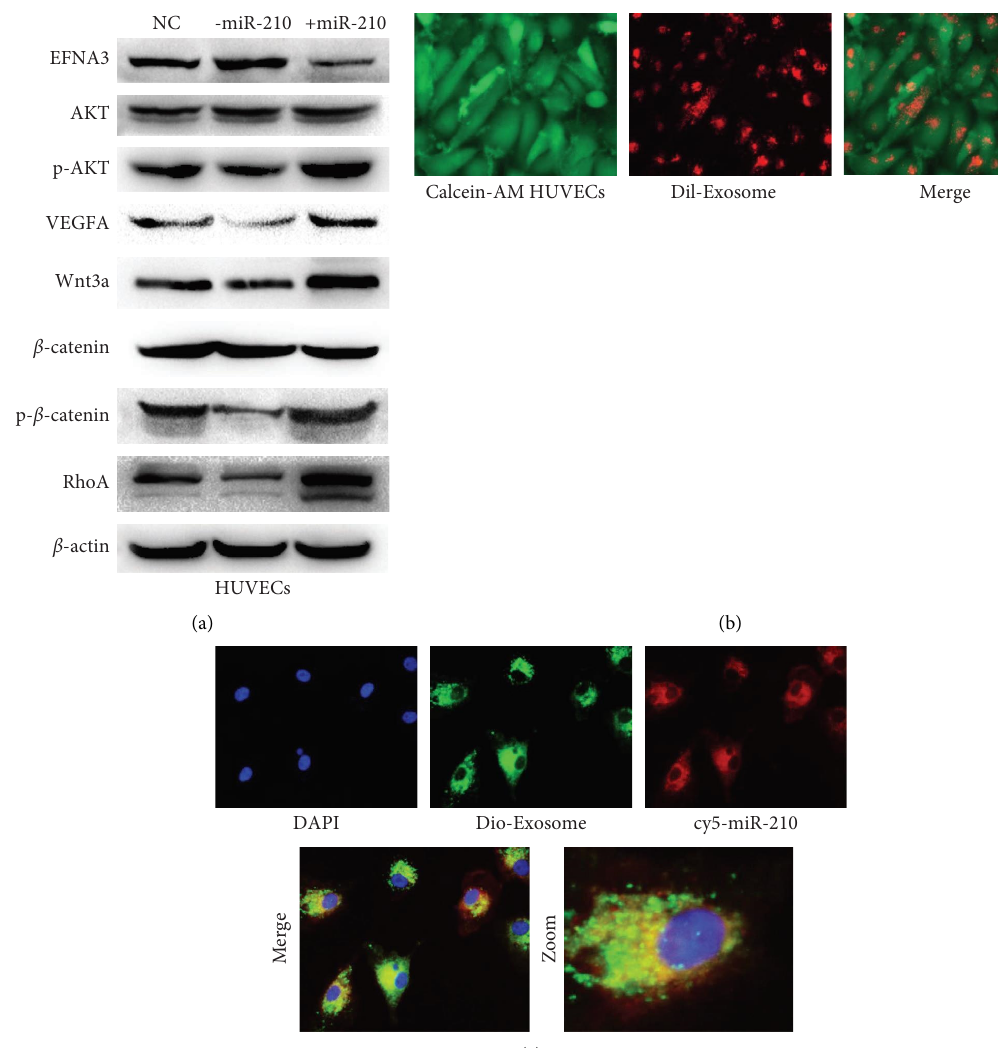
Figure 6: miR-210 or EFNA3 participates in the PI3K/AKT/VEGFA or Wnt/ Β -catenin/RHOA pathways. (a) Relative indicated protein expression in the indicated HUVECs was measured by WB analysis. (b) Dil-labeled exosomes were added to Calcein AM-labeled HUVECs for cocultivation. Images were captured with a fuorescence microscope, and the white arrows indicate exosomes. Magnifcation, × 100. (c) Dio-labeled exosomes of ov cy5-miR-210 Hs766T were added to HUVECs for cocultivation. Images were captured with a fuorescence microscope. Te green arrow indicates exosomes, and the pink arrow indicates cy5-miR signals. Magnifcation, ×